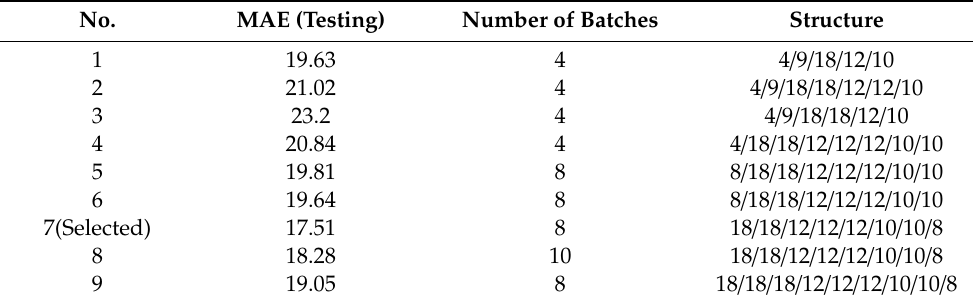
Table 5. Empirical process for finding the DNN